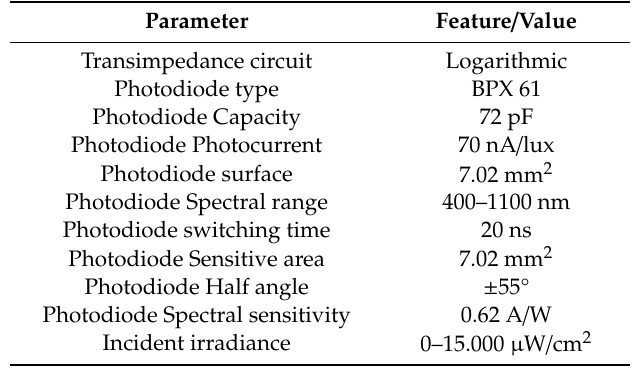
Table 3. Summary of the VLC receiver parameters during the tests.